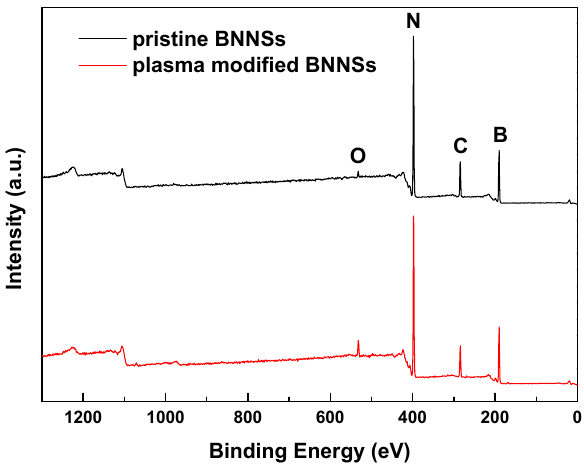
Figure 6. XPS survey spectra of pristine BNNSs and plasma modified BNNSs.